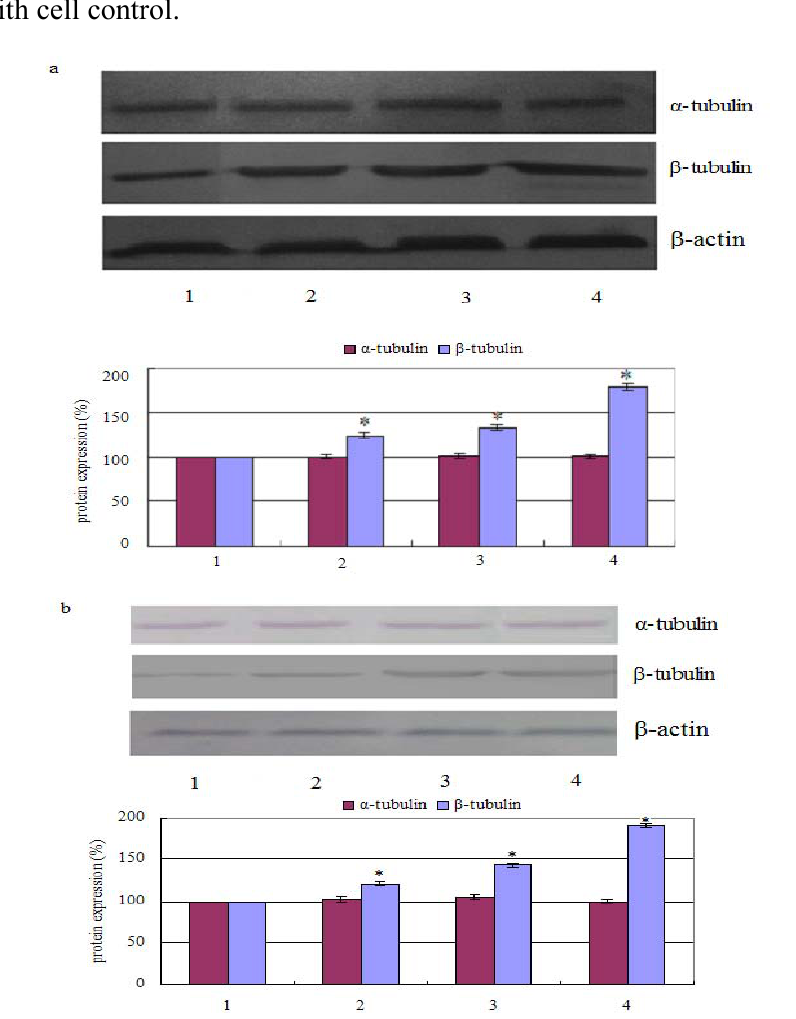
Figure 2. Effect of chamaejasmine on α -tubulin and β -tubulin activities by Western blotting assay, PC-3 cells were treated with chamaejasmine (0, 1, 2, 4 µM) for 72 h ( a ); PC-3 cells were treated with chamaejasmine for 0, 24, 48 and 72 h ( b ). * P < 0.05 compared with cell